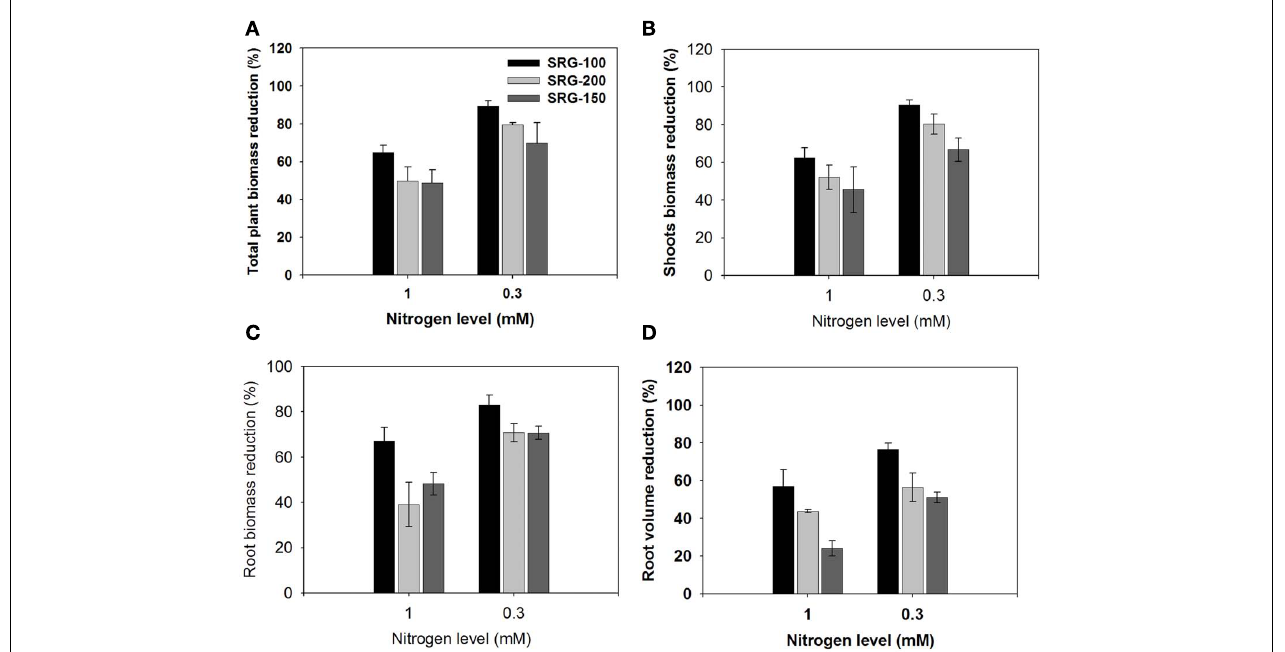
genotype growing under optimal N condition. (A) Reduction in the total plant dry biomass. (B,C) shoot and root biomass reduction (D) , root volume reduction. Data are means ± SD ( n =